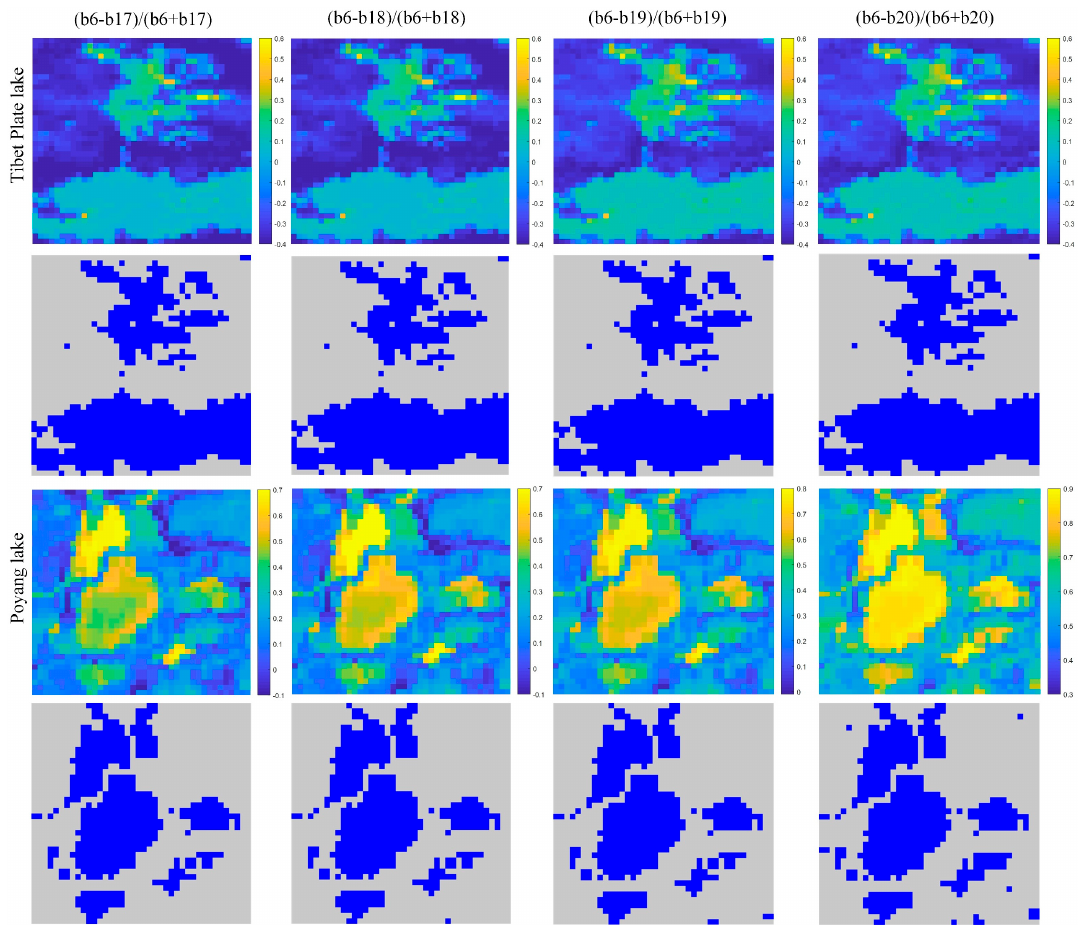
Figure 5. NDWI images based on NIR bands of 17, 18, 19 and 20, and corresponding water body maps generated by OTSU segmentation. Table 2. Accuracy assessment of the water body maps produced by OTSU segmentation with different NDWI images for Tibet Plate lake and Poyang lake.